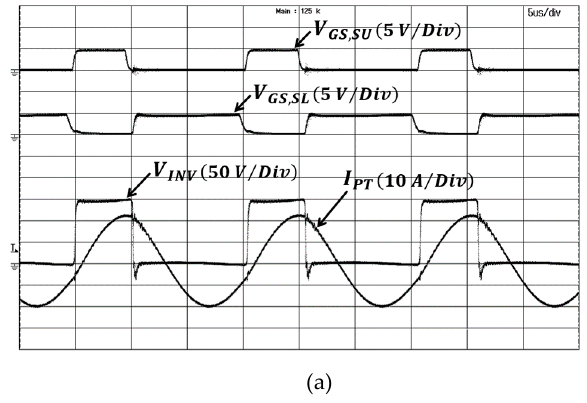
Figure 16. Experimental setup: ( a ) Overall system; ( b ) Multiple transmitter coils; ( c ) Single receiver coil.